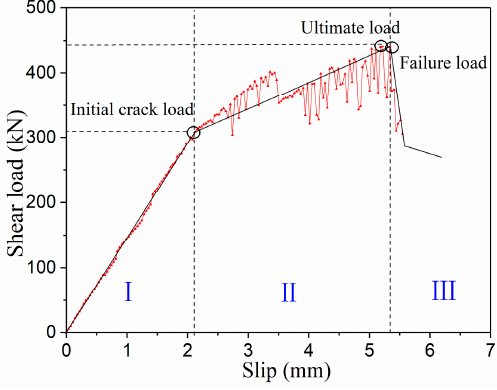
Figure 10. UHPC shear load–slip curve.